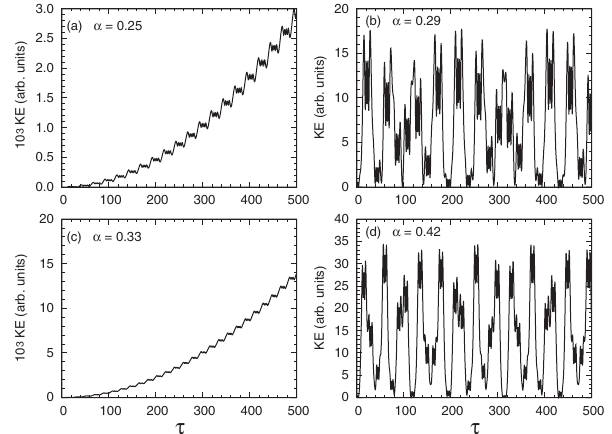
FIG. 3. Temporal evolution of transverse kinetic energy of proton for (a) three different phase modulation factor (cid:3) ¼ 1 =n with n ¼ 2 , 3, and 4 being an integer; similarly the case when n is not an integer is also presented (b). The amplitude of the EM wave a 0 ¼ 0 : 1 and constant magnetic field along wave propa- gation b 0 ¼ 1 : 0 is considered.